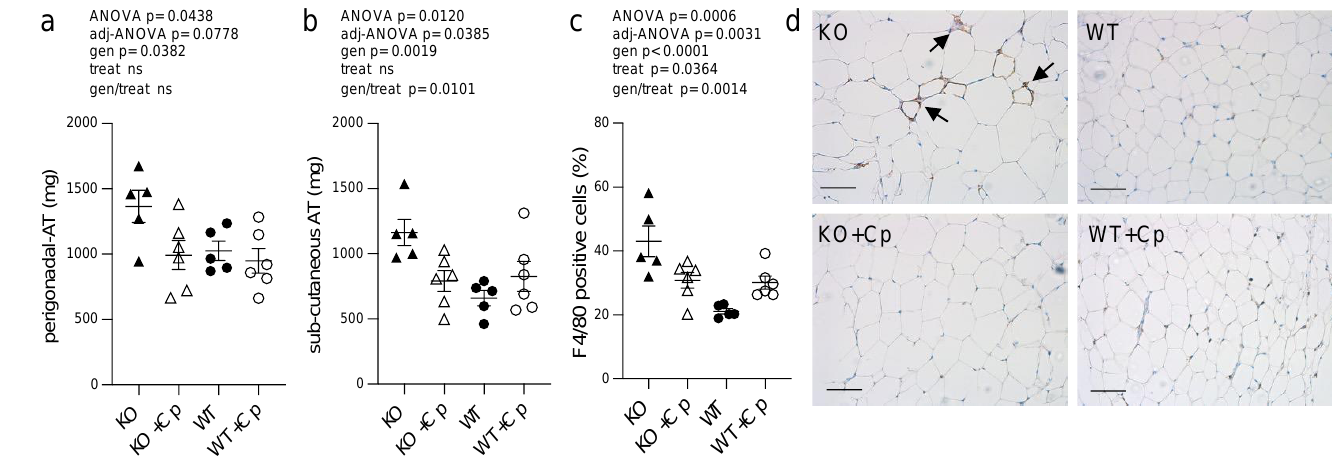
Figure 5. CpKO mice show adipose tissue accumulation and macrophage infiltration, which are reduced by Cp treatment. ( a ) Weight of perigonadal adipose tissue (pgAT) and ( b ) subcutaneous adipose tissue (sub-cAT) collected from mice at 10 months of age after 2 months of treatment with an intraperitoneal injection of Cp 5 µ g/g, administered every 5 days (KO+Cp; WT+Cp) or saline (KO, WT). ( c ) Quantitation of F4/80 macrophage marker staining reported as a percentage of positive cells in pgAT, performed with QuPath software. ( d ) Representative immunohistological section of pgAT stained for the F4/80 macrophages marker (brown) and counterstained with hematoxylin (blue). Arrows indicate clusters of infiltrating macrophages. The representative images in panel d were filtered using the “white balance correction 1.0” macro from ImageJ software. Data: mean ± SEM of animal groups, each dot corresponds to one animal (CpKO, WT n = 5; CpKO+Cp, WT+Cp, n = 6); statistical p -values were evaluated by two-ways ANOVA and reported as value for overall ANOVA, value for Benjamini-Hochberg adjustment for multiple ANOVA tests related to adipose tissue features (adj-ANOVA), for genotype variable (gen), for treatment variable (treat) and for the interaction of genotype/treatment (gen/treat). Scale bars= 100 µm.